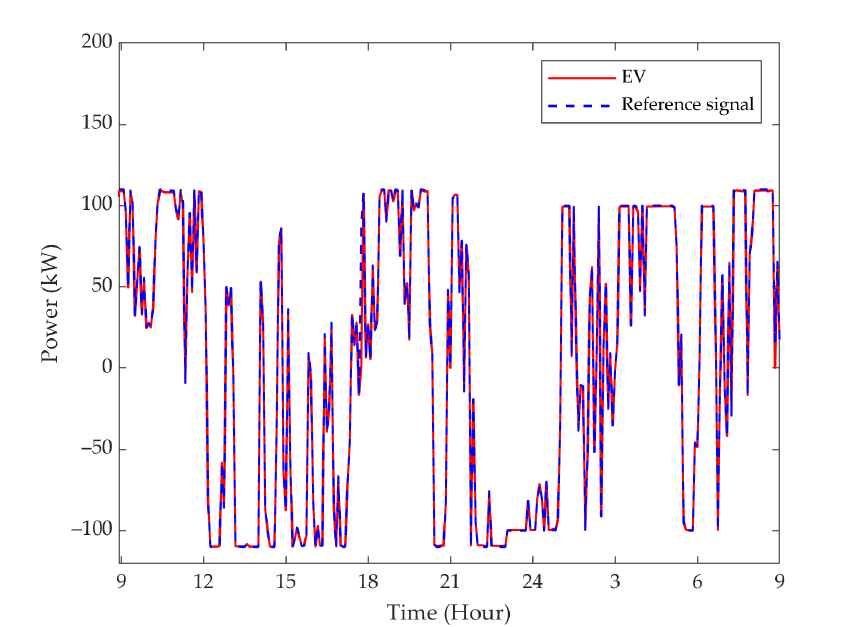
Figure 11. Aggregated EV charging and discharging profile for frequency regulation in Scenario #4.